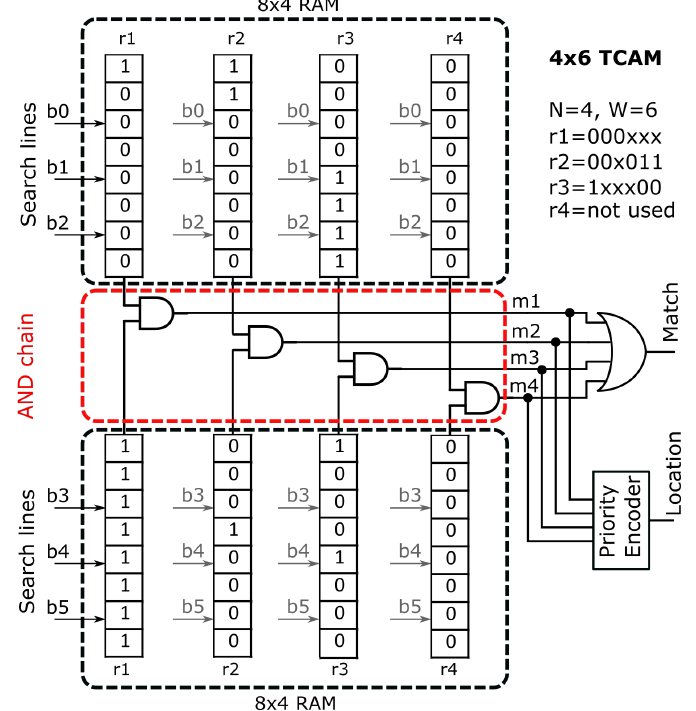
Figure 2. Example of a 4 × 6 TCAM emulated using two 8 × 4